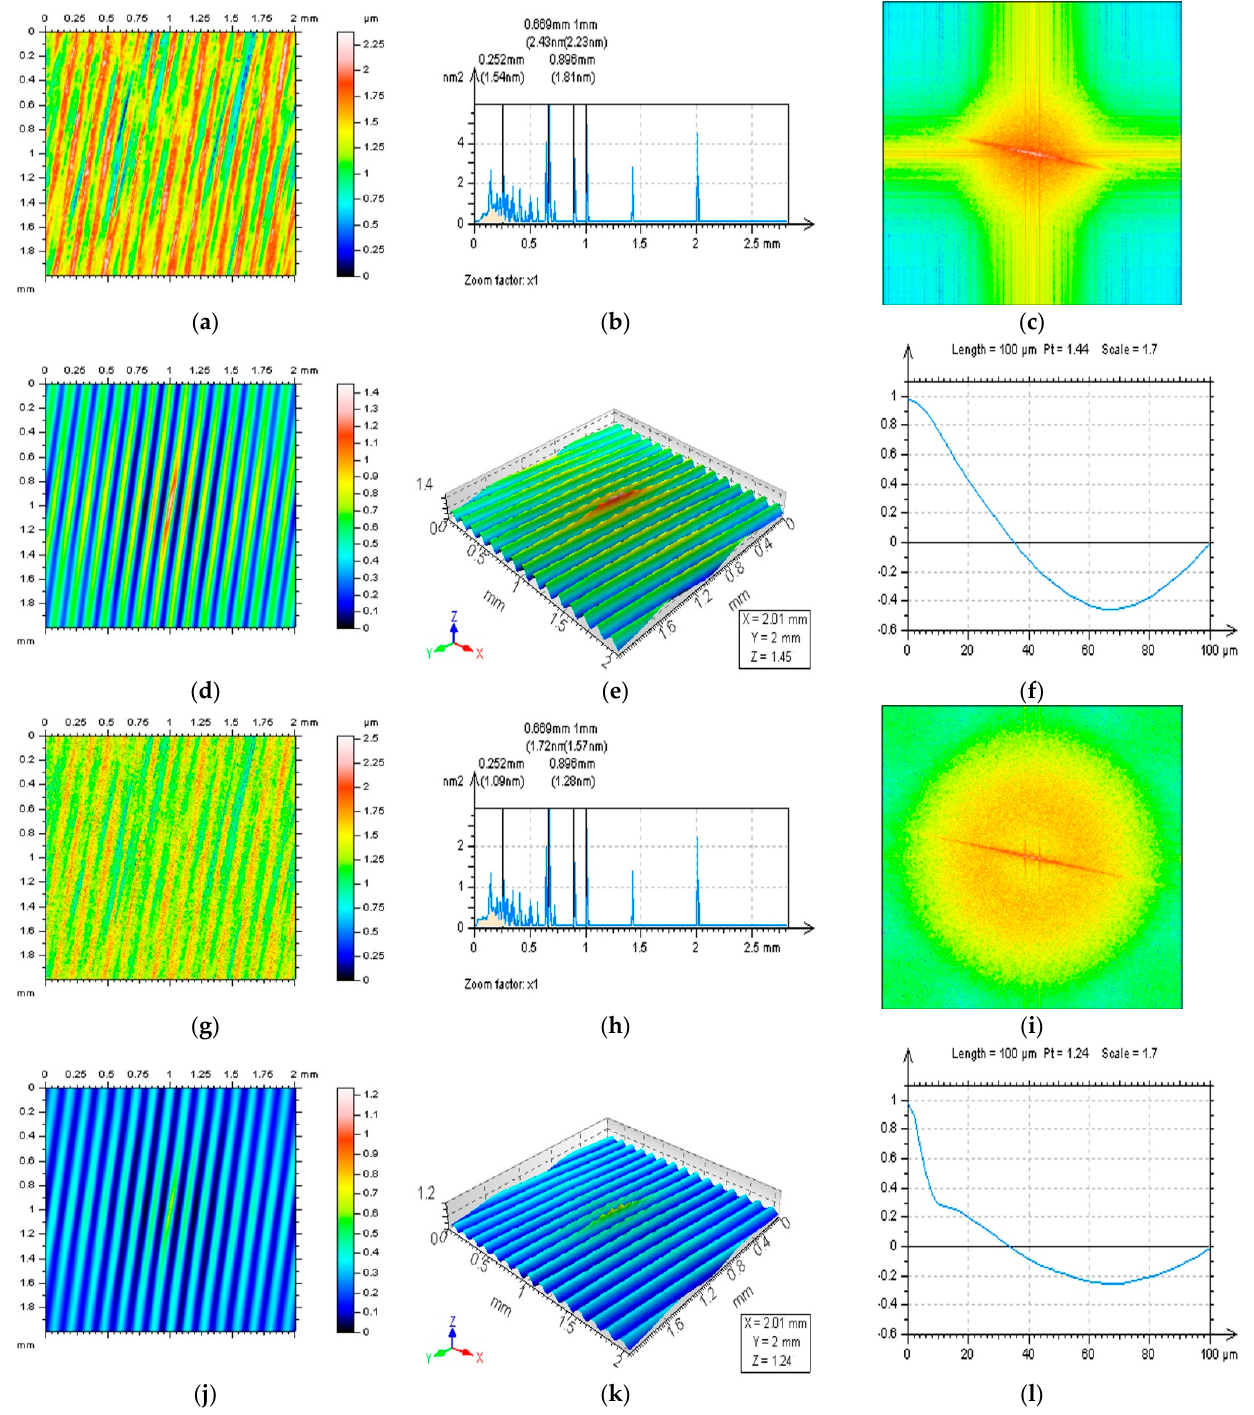
Figure 1. Contour map plots ( a , g ), PSDs ( b , h ), FS ( c , i ) and map plots ( d , j ), isometric view ( e , k ) and centre–profiles ( f , l ) of ACFs received from raw measured data of milled surface ( a – f ) and the same surface with a high ‐ frequency noise ( g – l ).